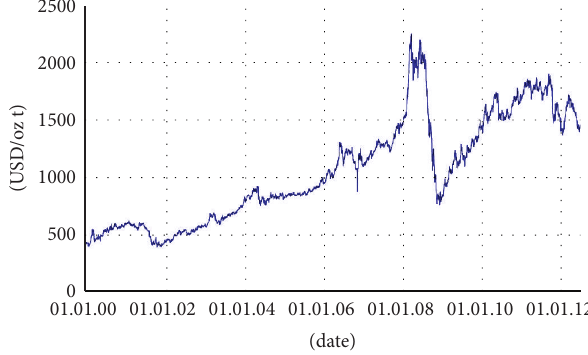
Figure 2: Development of the price of platinum (USD/oz t) in the past 12 years [10] (used with permission from http://www